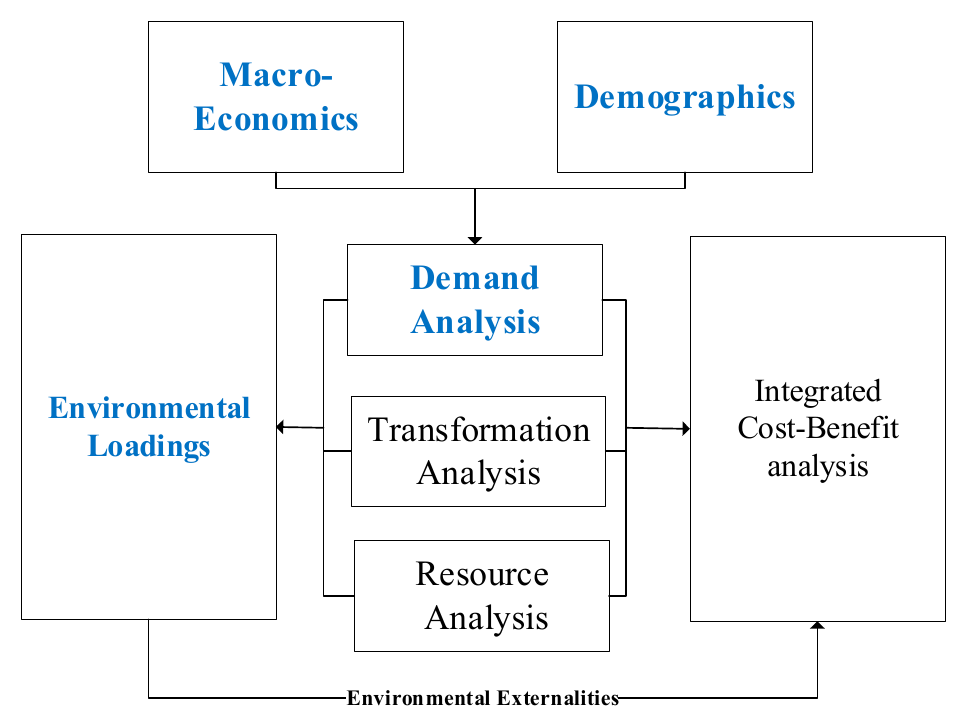
Figure 4. The Structure of LEAP’s Calculations.